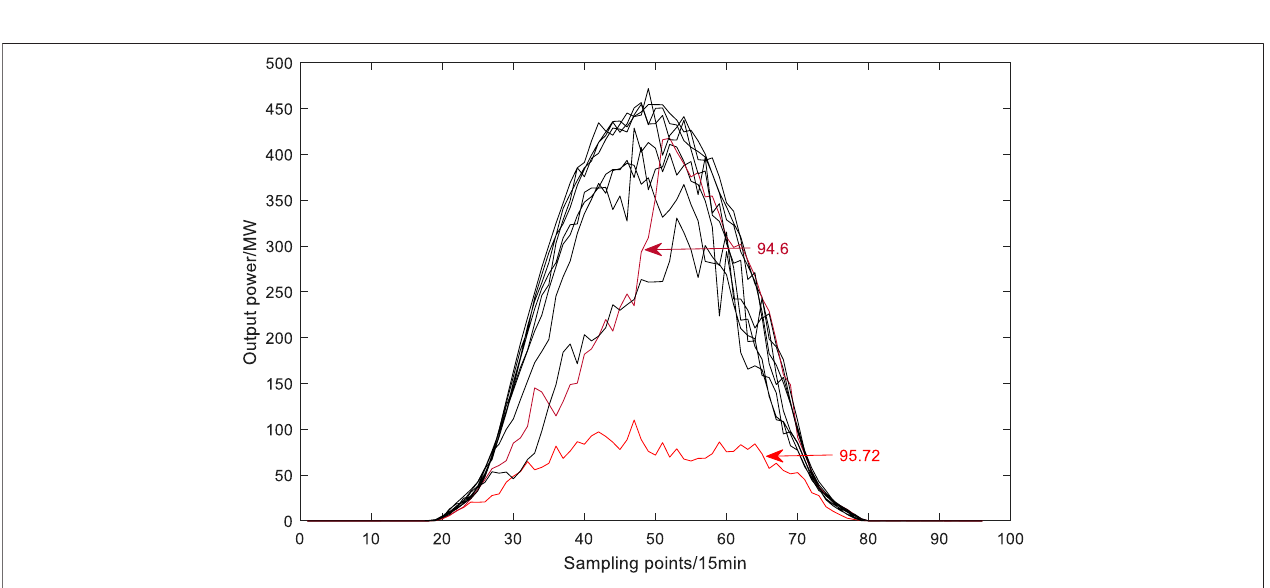
FIGURE 7 | Daily curves for observed cluster total output power from 21 to 30